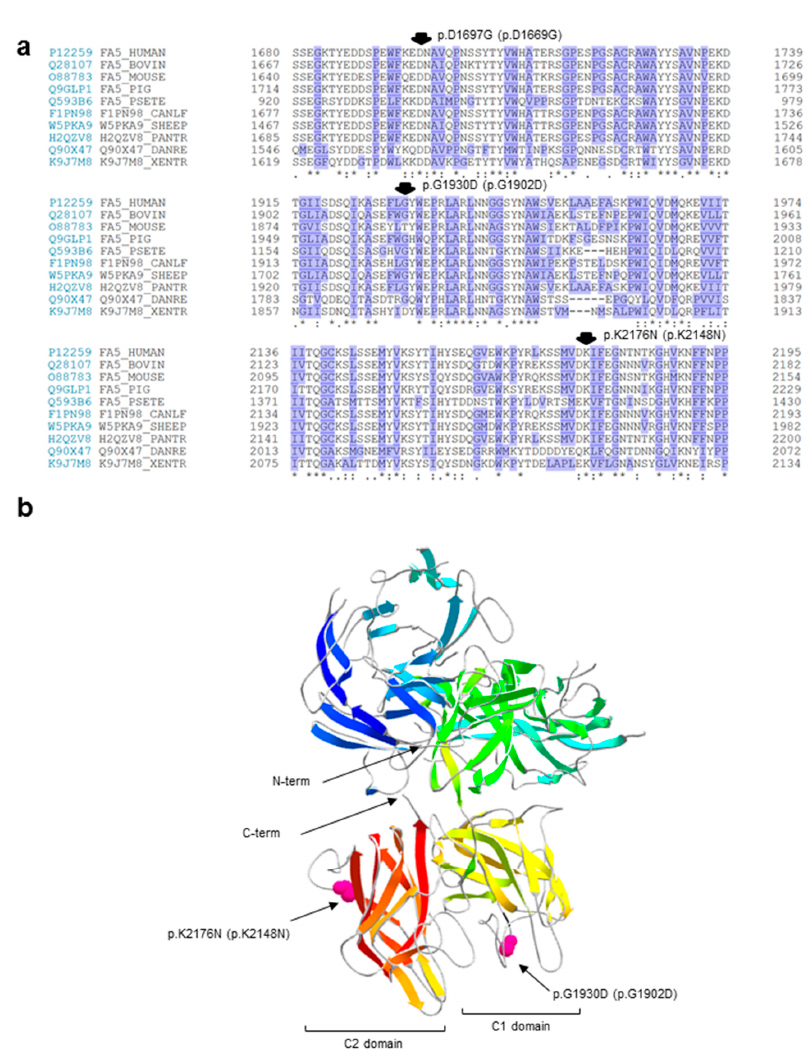
Figure 1. In silico charaterization of the putative missense mutations. ( a ) Multiple alignments of regions of coagulation FV that are 50 amino acids long from several vertebrates harboring the three identified missense variants. Protein sequences were obtained from the UniProt database (https: //www.uniprot.org/) under the accession numbers P12259 (human, Homo sapiens ), Q28107 (bovin, Bos taurus ), O88783 (mouse, Mus musculus ), Q9GLP1 (pig, Sus scrofa ), Q593B6 (psete, Pseudonaja textilis ), F1PN98 (canlf, Canis lupus familiaris ), W5PKA9 (sheep, Ovis aries ), H2QZV8 (pantr, Pan troglodytes ), Q90X47 (danre, Danio rerio ), and K9J7M8 (xentr, Xenopus tropicalis ). Residues are numbered, including the signal peptide. Conserved amino acids are indicated by asterisks (perfect identity among species), colons (high conservation), and dots (low conservation). Hydrophobic residues are shaded in violet. The three identified missense variants are indicated by arrows and according to their native and mature protein numbering. ( b ) Ribbon diagrams of the secondary and tertiary structures of the bovine inactive FVa (FVai) are shown. The positions of two out of three putative missense mutations are indicated in pink (the region harboring the p.D1669G variant is not included in the FVai structure). Mutation numbering refers to the highly homologous human structure. The color code indicates the different FVai domains (shades of yellow and red point to the C1 and C2 domains, respectively). The amino-termini (N) and carboxy-termini (C) of the entire structure are also